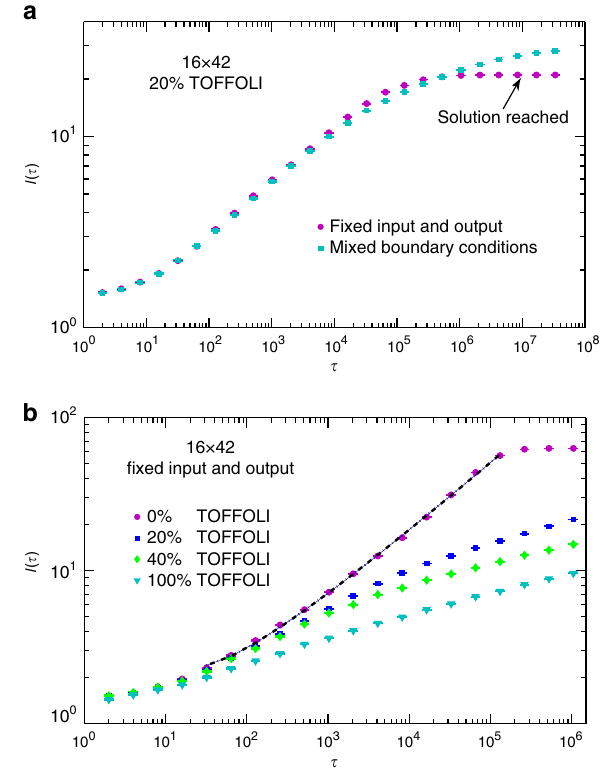
Figure 5 | Effects of boundary conditions and TOFFOLI concentration. ( a ) The saturation of the scaling curve for fixed-input and output boundary conditions with 20% TOFFOLI gates when ‘ ð t Þ (cid:6) W = 2. This indicates that the solutions have been reached, and is consistent with the domain growth picture. Notice that for mixed input and output boundary conditions, the curve does not saturate when ‘ ð t Þ (cid:6) W = 2. ( b ) The functional form of the scaling curves as a function of different TOFFOLI concentrations. The correlation grows more slowly as the concentration of TOFFOLI gates increases. The dashed line corresponds to the fitting